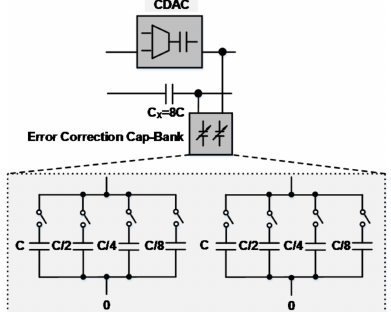
Figure 10. Error correction capacitor